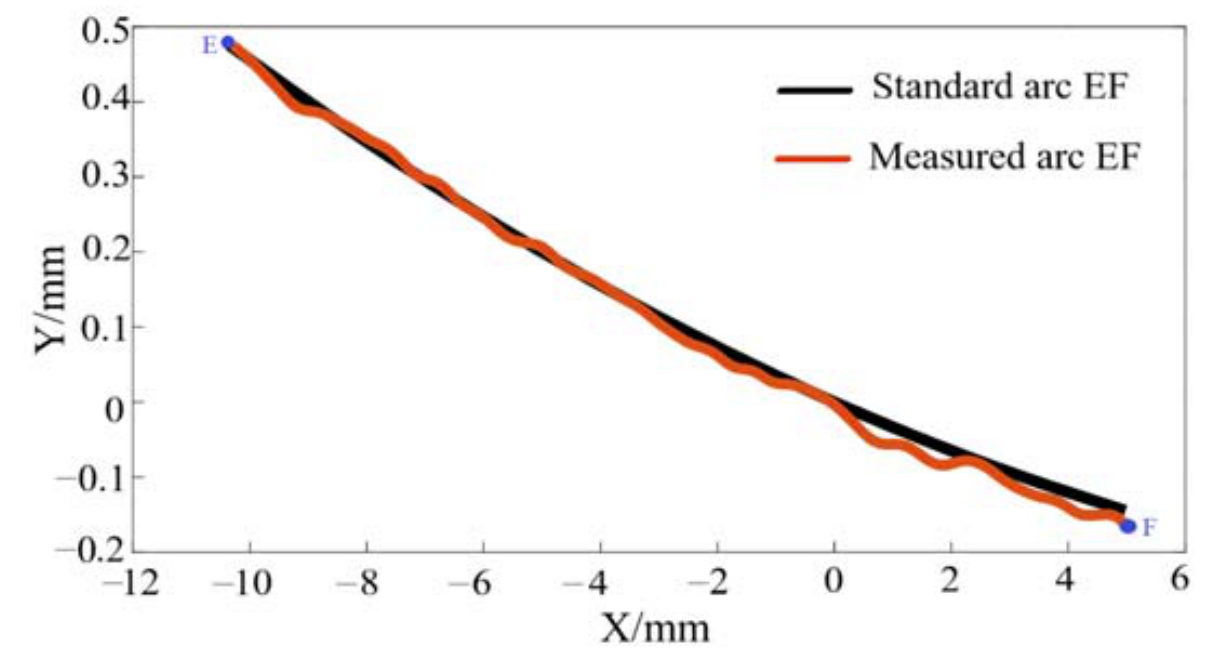
Figure 14. The result of fitting circle to arc EF of LM A type.